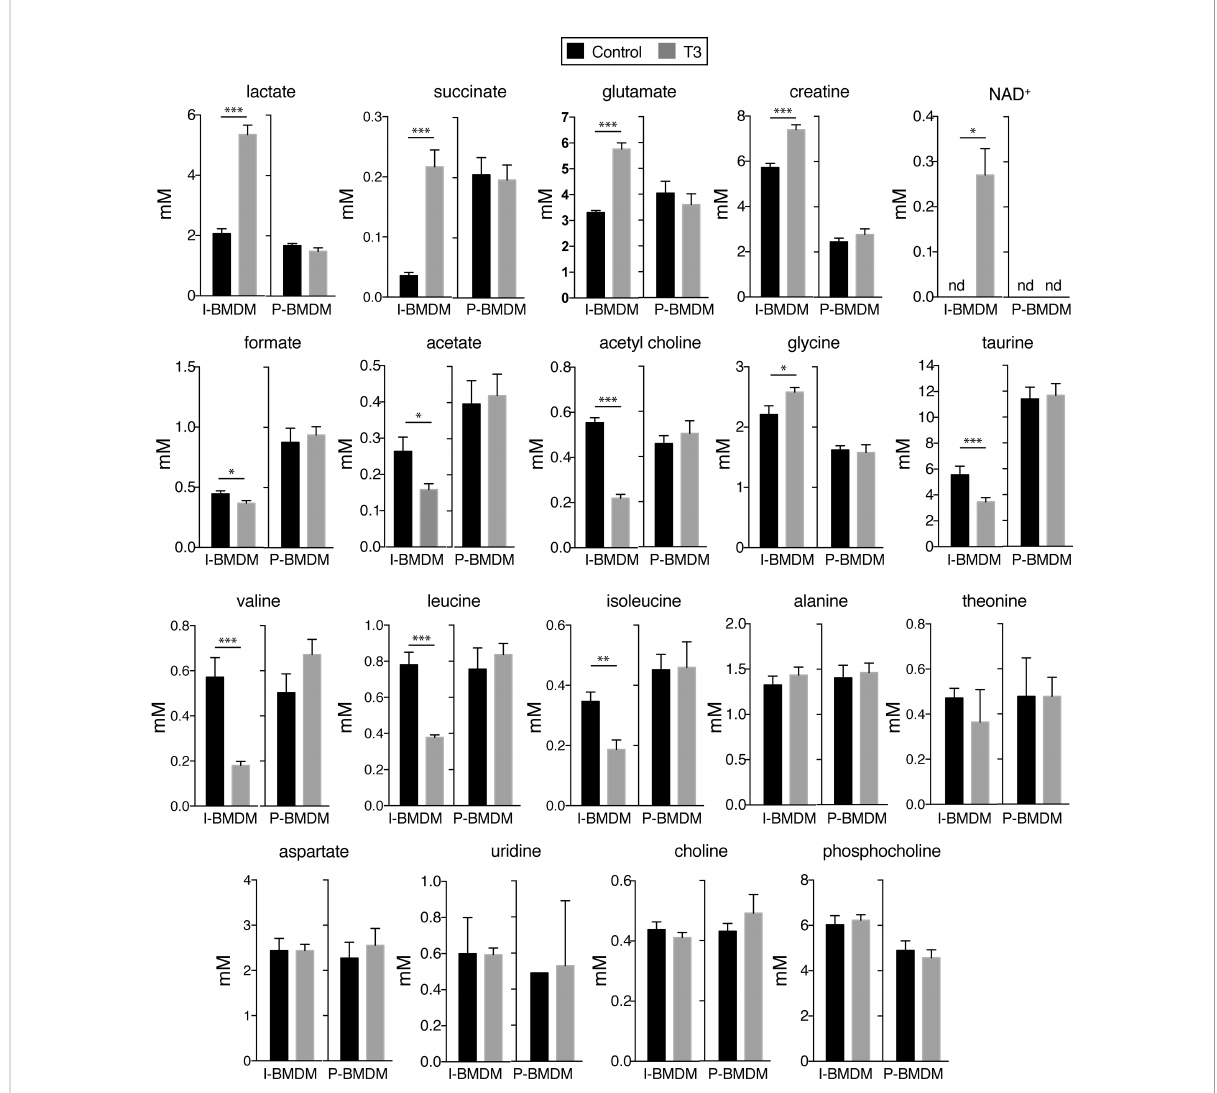
FIGURE 4 T3 regulates the levels of low molecular weight metabolites in immortalized but not in primary macrophages. Primary BMDM (P-BMDM) were differentiated in complete medium, shifted to hormone-depleted medium and incubated with (n=6) and without (n=6) 10 nM T3 for 48 h. Immortalized BMDM (I-BMDM) were also incubated without (n=5) or with T3 (n=6) in hormone-depleted medium for the same time period. Intracellular concentrations (mM) of the indicated metabolites, corrected by cell number, were determined in I-BMDM and P-BMDM by nuclear magnetic resonance spectroscopy. Data are means ± SD. *p < 0.05, **p < 0.01, ***p <